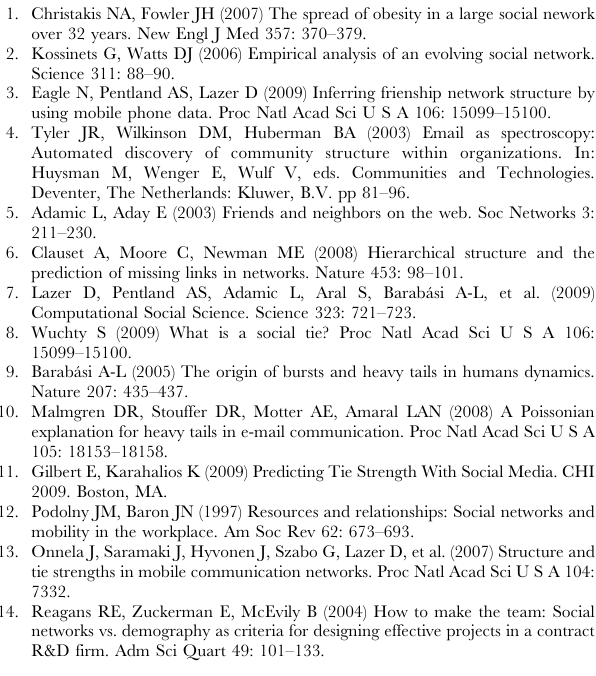
Table S3 We show Pearson’s correlations between a person’s self-reported and email derived network characteristics for the 31 partners in the same office, utilizing the time-resolved total volume (tVM), reciprocation (tRM) and normalization method